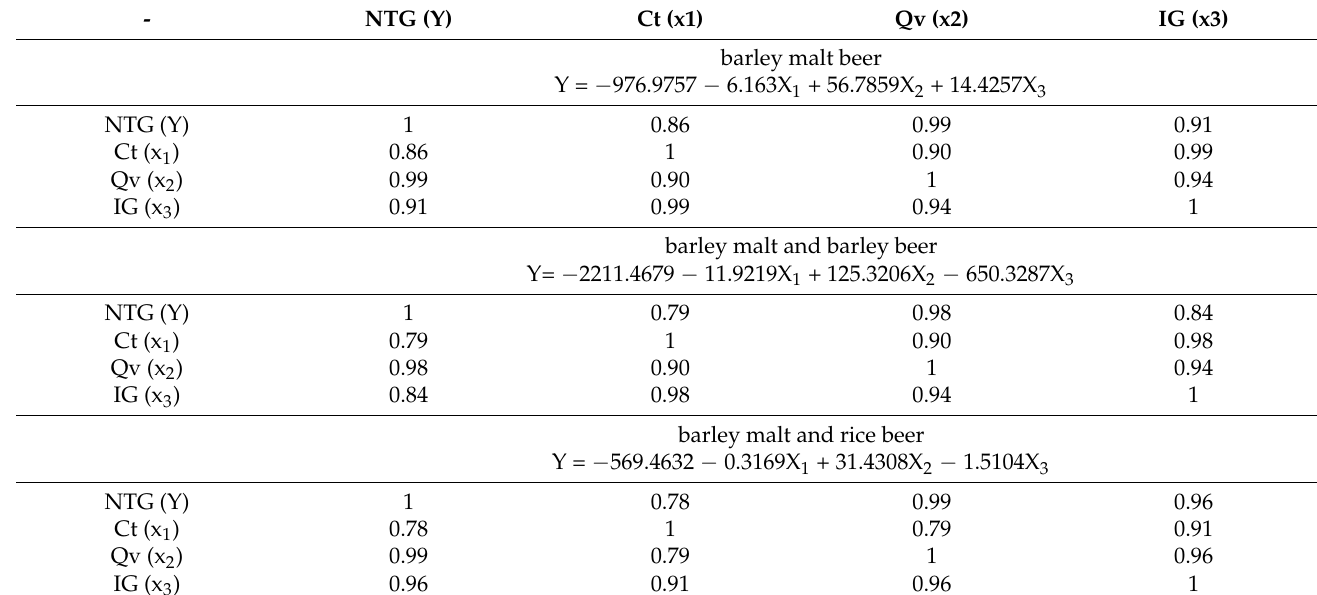
Table 7. Samples of pairwise correlation coefficients (reliability limit p <